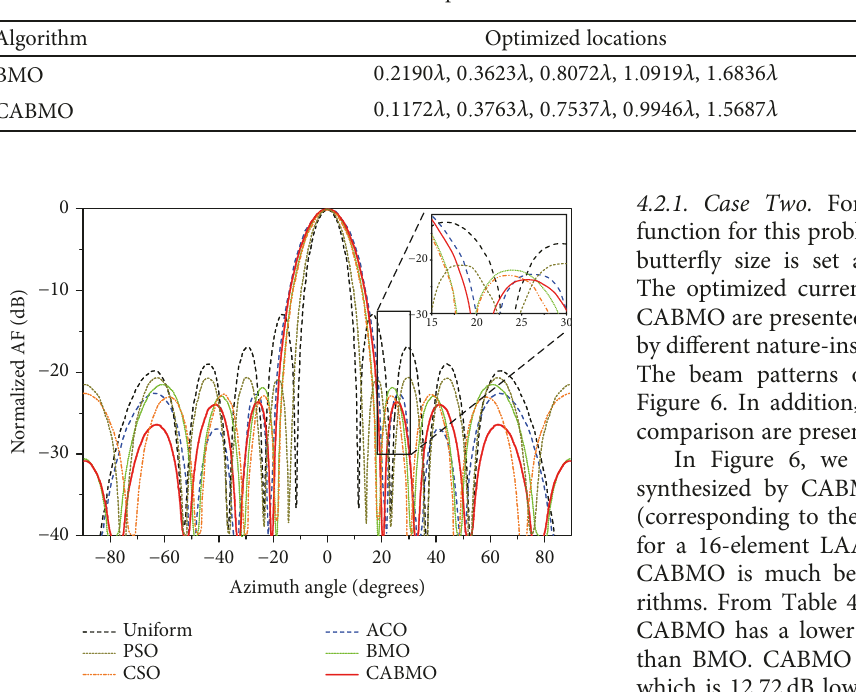
Table 2: The optimized results of the 10-element LAA for case